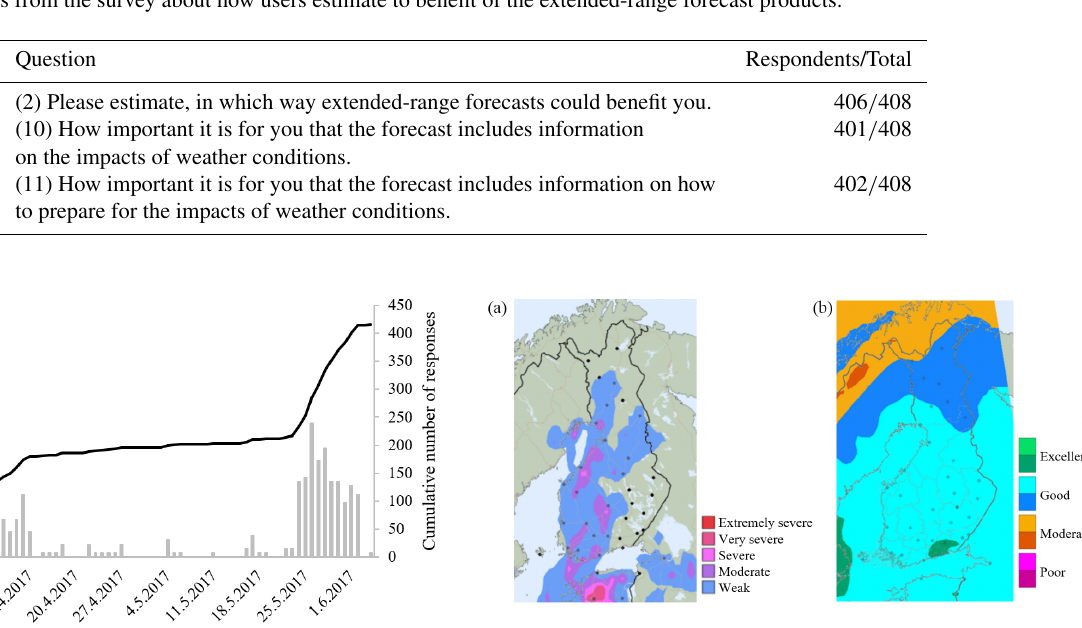
Figure 3. Two examples of extended-range impact forecast proto- types. Thunderstorm outlook (a) and sport weather outlook (b)